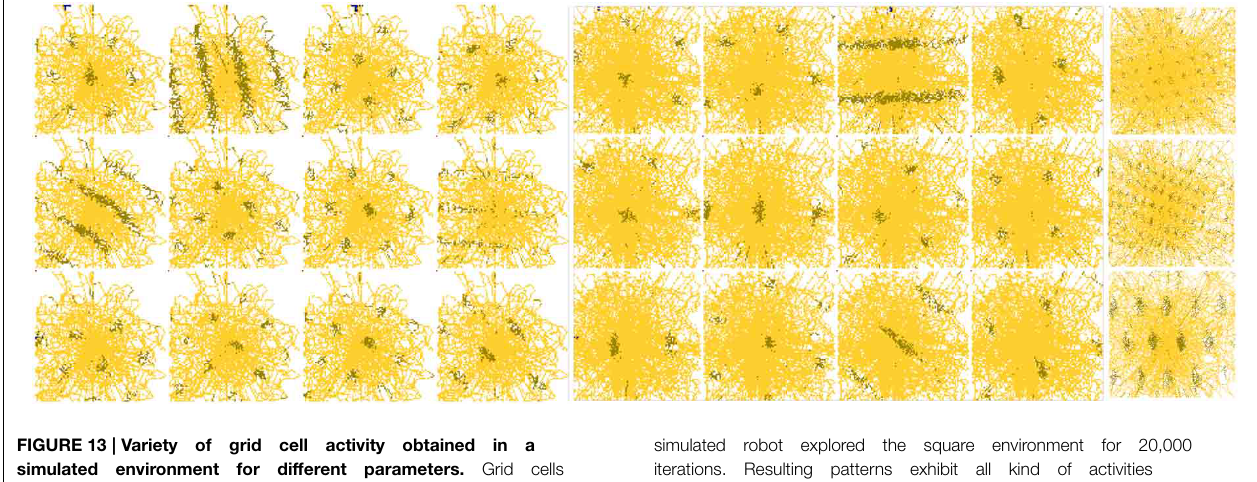
(including grid-like with different spatial periods, phases, gridness, and